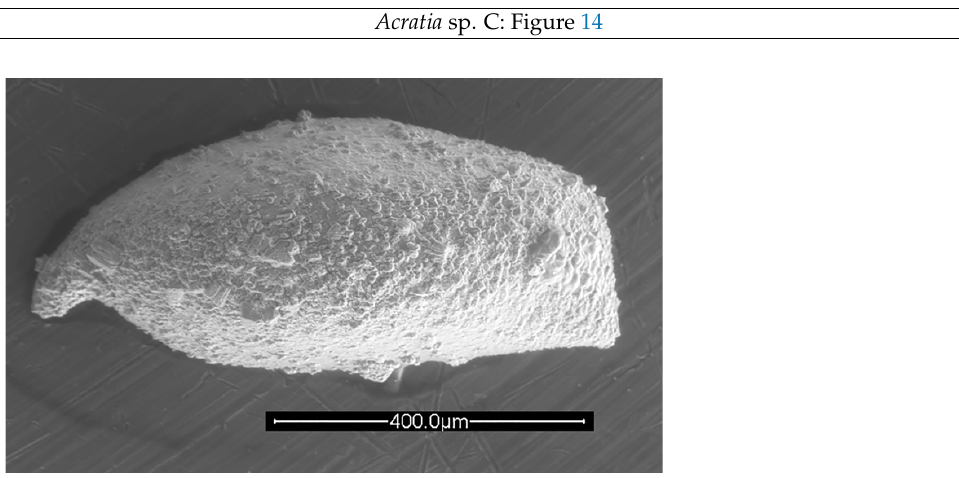
Figure 14. Acratia sp. C, left valve, lateral view. IGM 5011(10). Scanning electron micrograph (sec- ondary electrons). Scale bar = 400 microns. (secondary electrons). Scale bar = 400